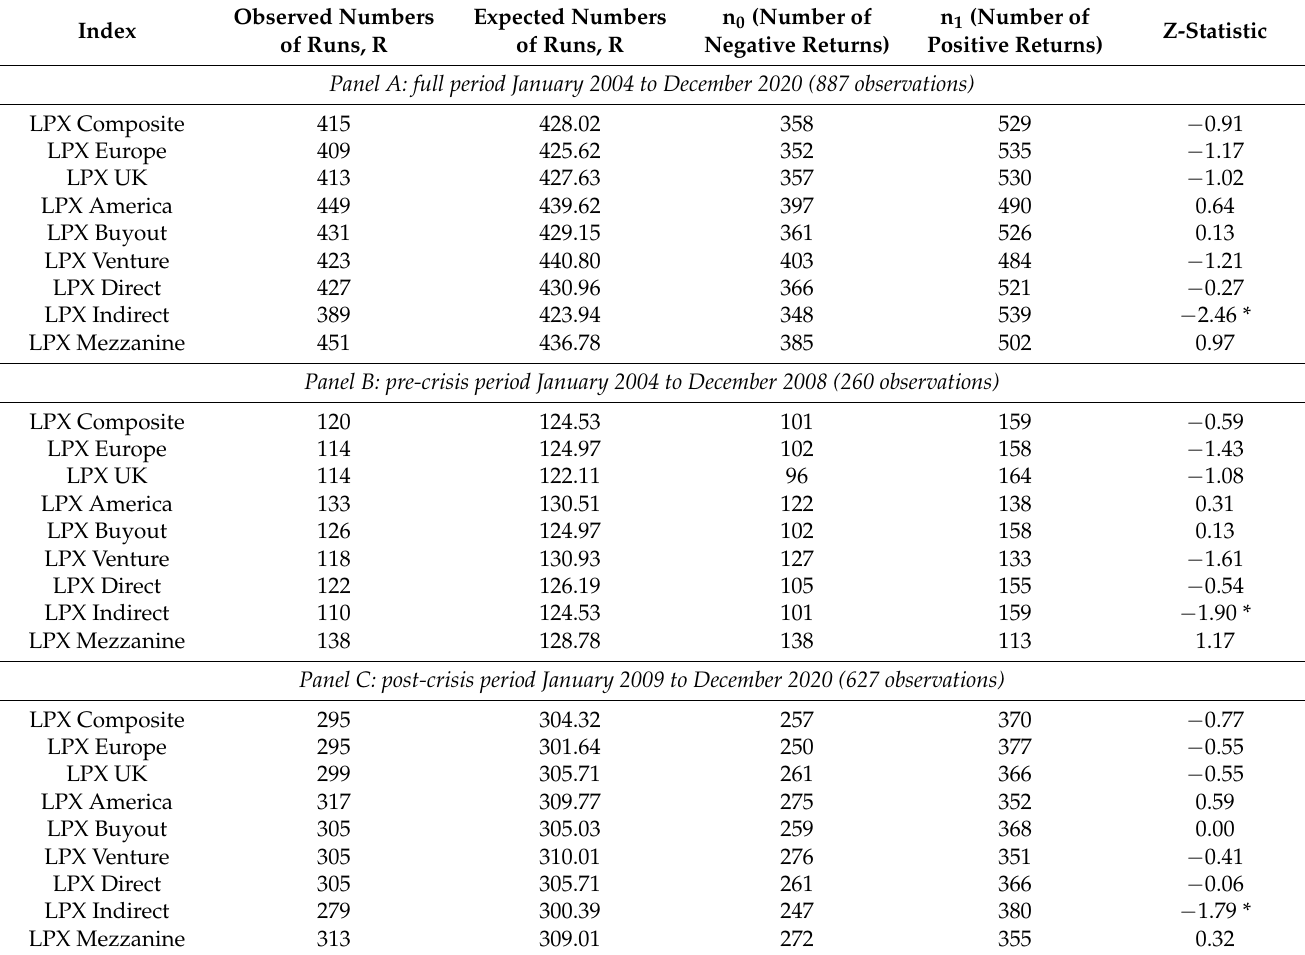
Table 7. Results of the runs test for listed private equity index